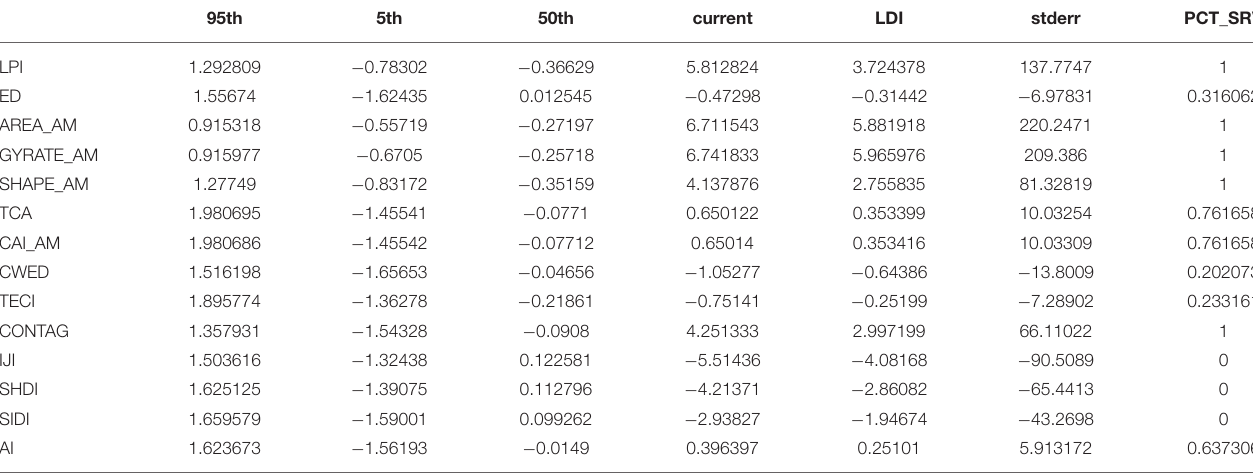
TABLE 3 | Simlulated range of variability of 16 landscape-level metrics. 95th 5th 50th current LDI